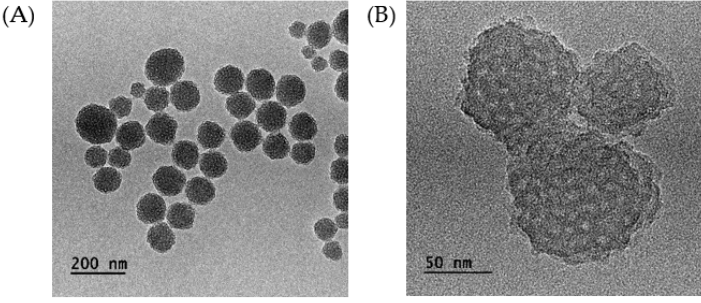
Figure 3. TEM images of ( A ) IBN-1-Cur-GA and ( B ) IBN-1-Cur-CP. Further, we used FT-IR spectroscopic investigations of Cur-embedded, amine-modified, acid-modified, and CP-loaded IBN-1 samples to demonstrate the successful immobilization of diverse organic functionalities (Figure 4).